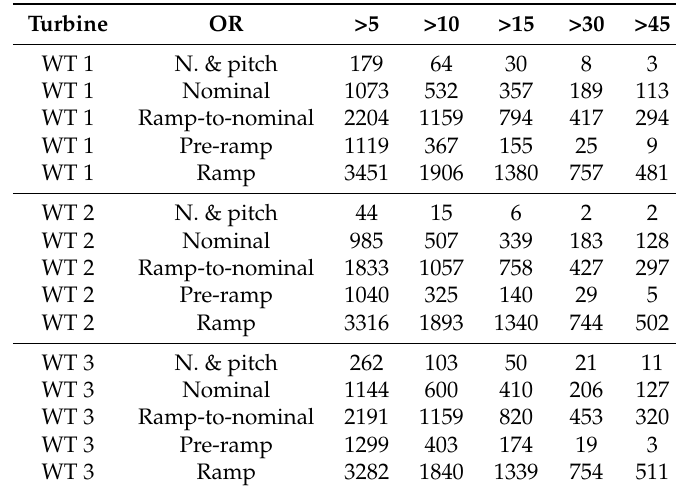
Table 3. Weekly OS frequency of different minimum times by each wind turbine (WT) and operation region